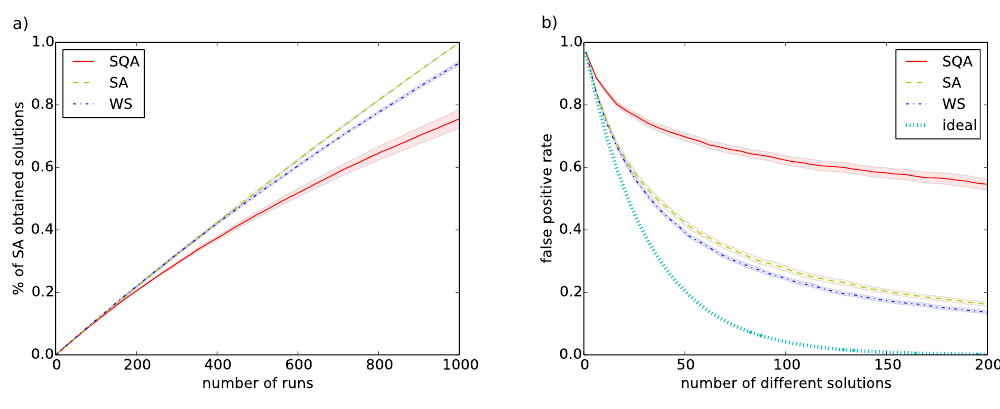
Figure 11: The plots are averaged over 20 randomly generated 5-SAT instances with n = 50 variables and a clauses-to-variables-ratio of α χ different solutions is shown and in b) the FPR is